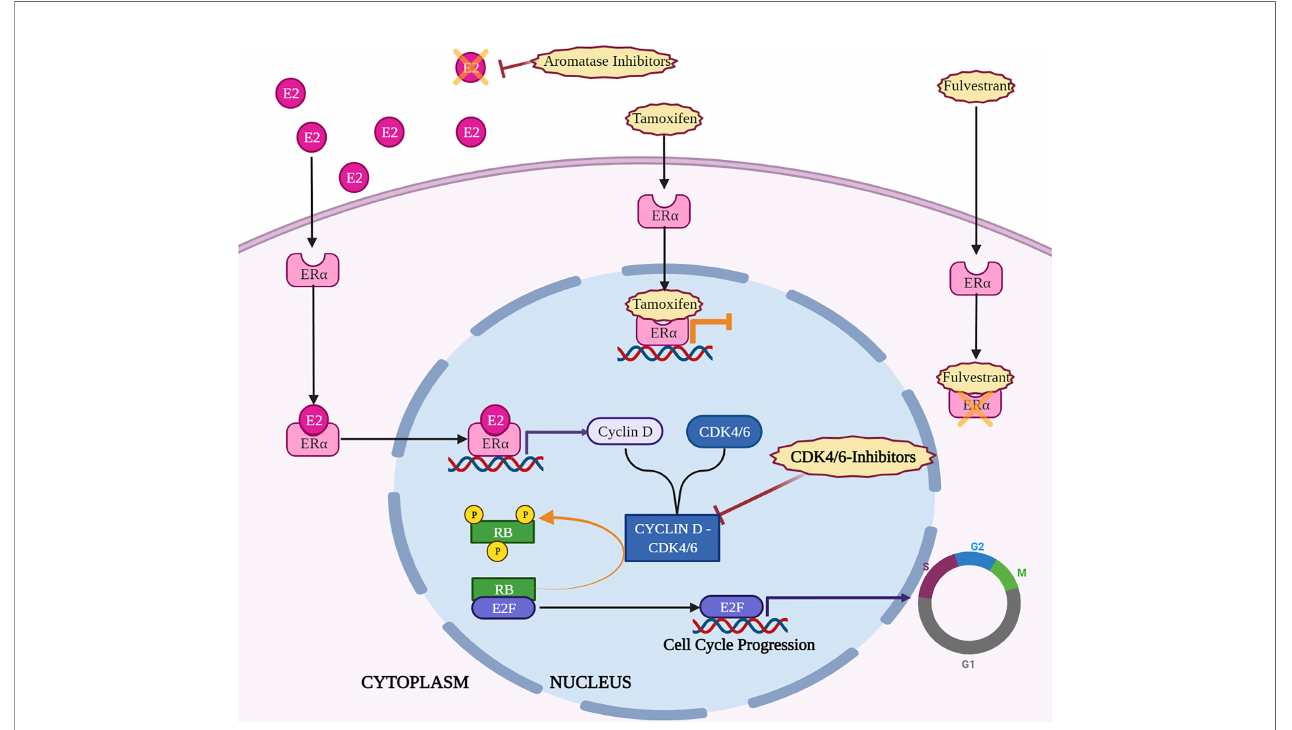
FIGURE 1 | Key mechanisms of action of endocrine therapy and CDK4/6-i in HR+ breast cancer. Created with